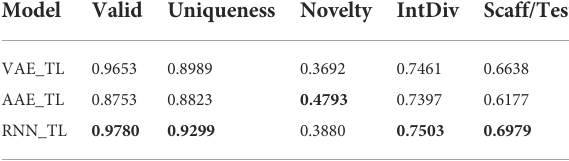
TABLE 2 Performance of each model with transfer learning.